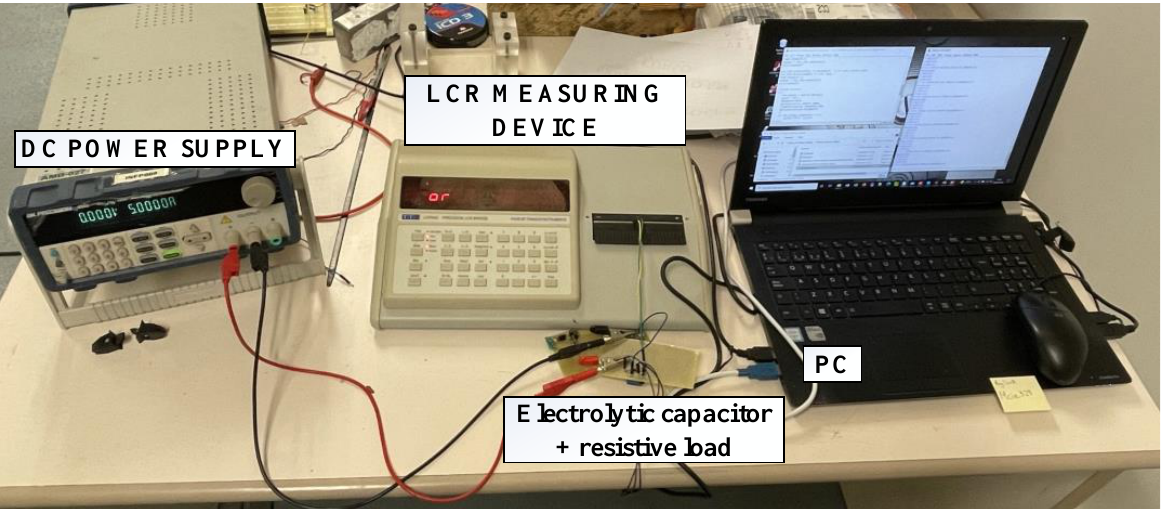
Figure 5. Experimental setup of the accelerated aging test.